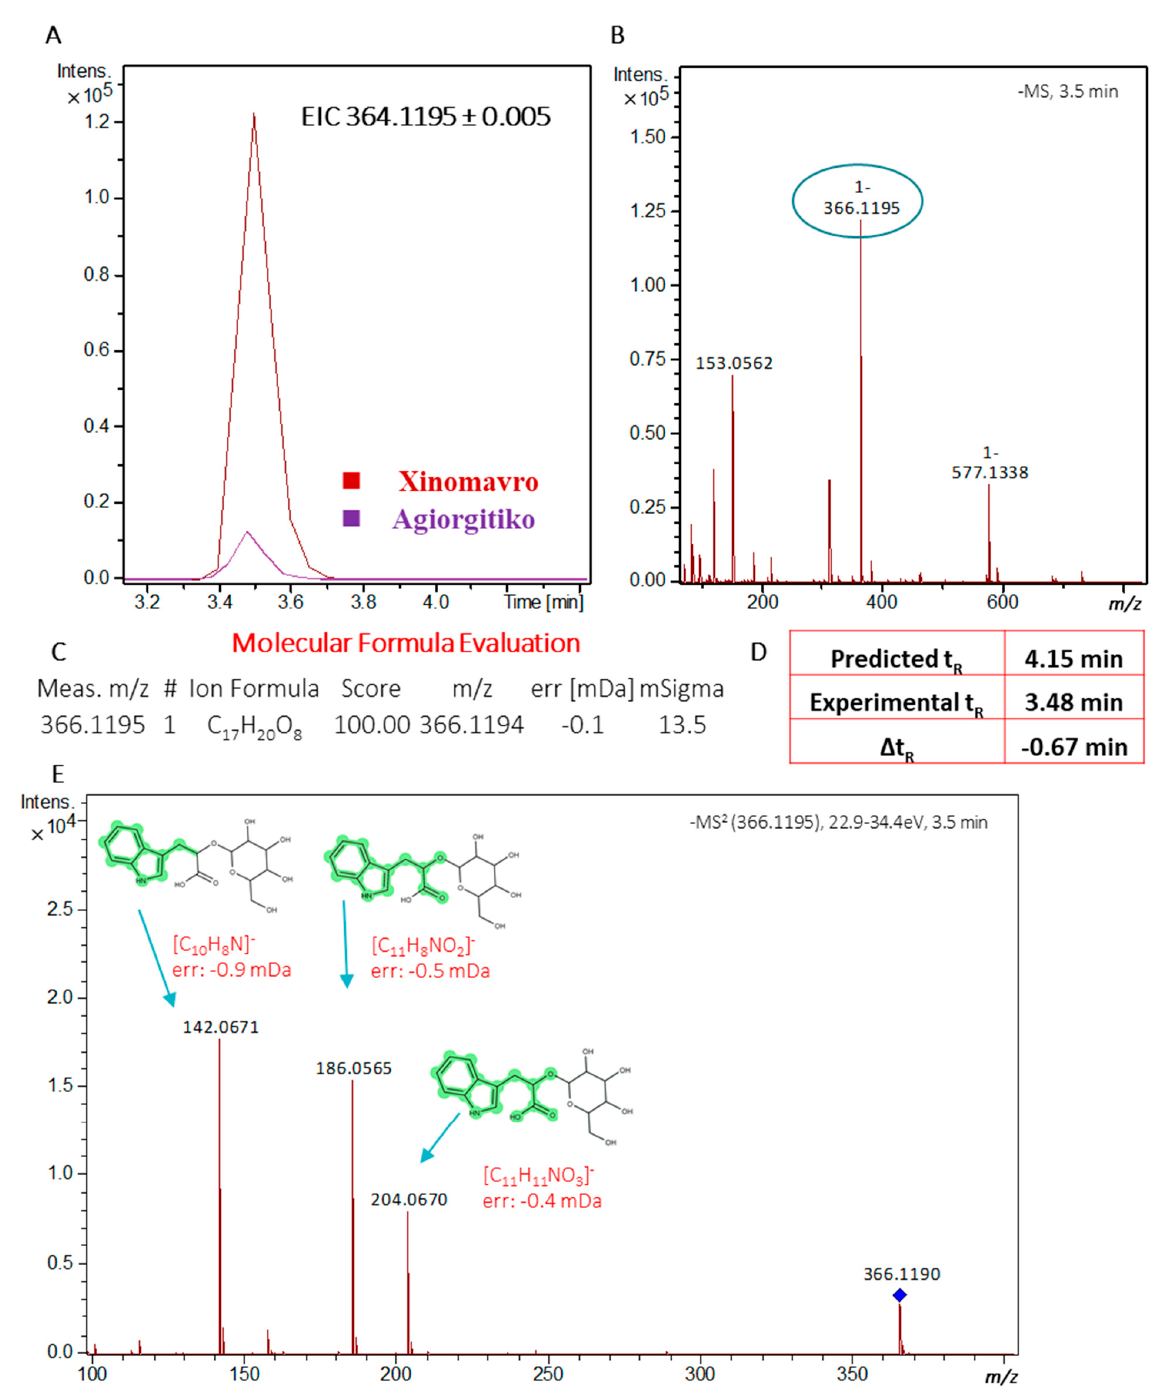
Figure 6. Identification data for the mass feature 366.1195_3.48 min (indolelactic acid glucoside: ( A ) Extracted Ion Chro- matogram (EIC) for the given mass ( ± 5 mDa) in Agiorgitiko and Xinomavro wine samples; ( B ) fullscan Mass Spectrometry (MS) chromatogram; ( C ) Molecular formula evaluation with Bruker Smart formula manually; ( D ) Comparison between experimental and predicted retention time values based on an in-house QSRR-based retention time prediction model ( E ) MS/MS spectra and corresponding fragments.